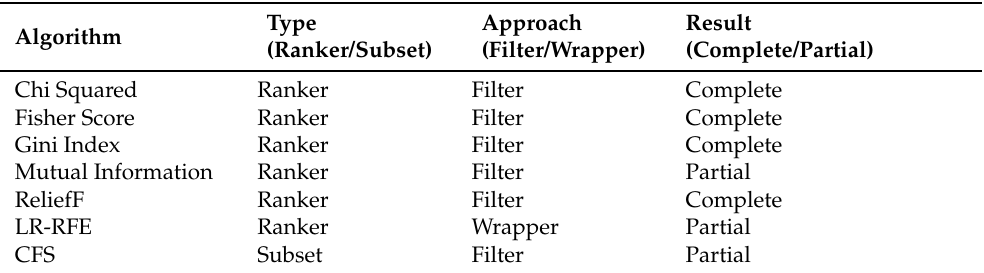
Table 2. List of the feature selection methods used, with a brief classification of the type, approach, and returned results. LR-RFE: Lasso Regression with Recursive Feature Elimination; CFS: Correlation- based Feature